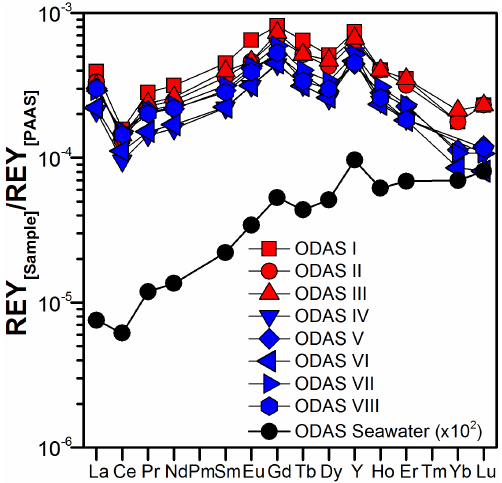
Figure 2. REY SN patterns of the ODAS seawater and of all pools of Mytilus edulis shells from the ODAS site (ODAS I to III shell pools were treated with NaOCl; ODAS IV to VIII shell pools were heated and had their periostracum manually removed). Note the similarity between all REY SN